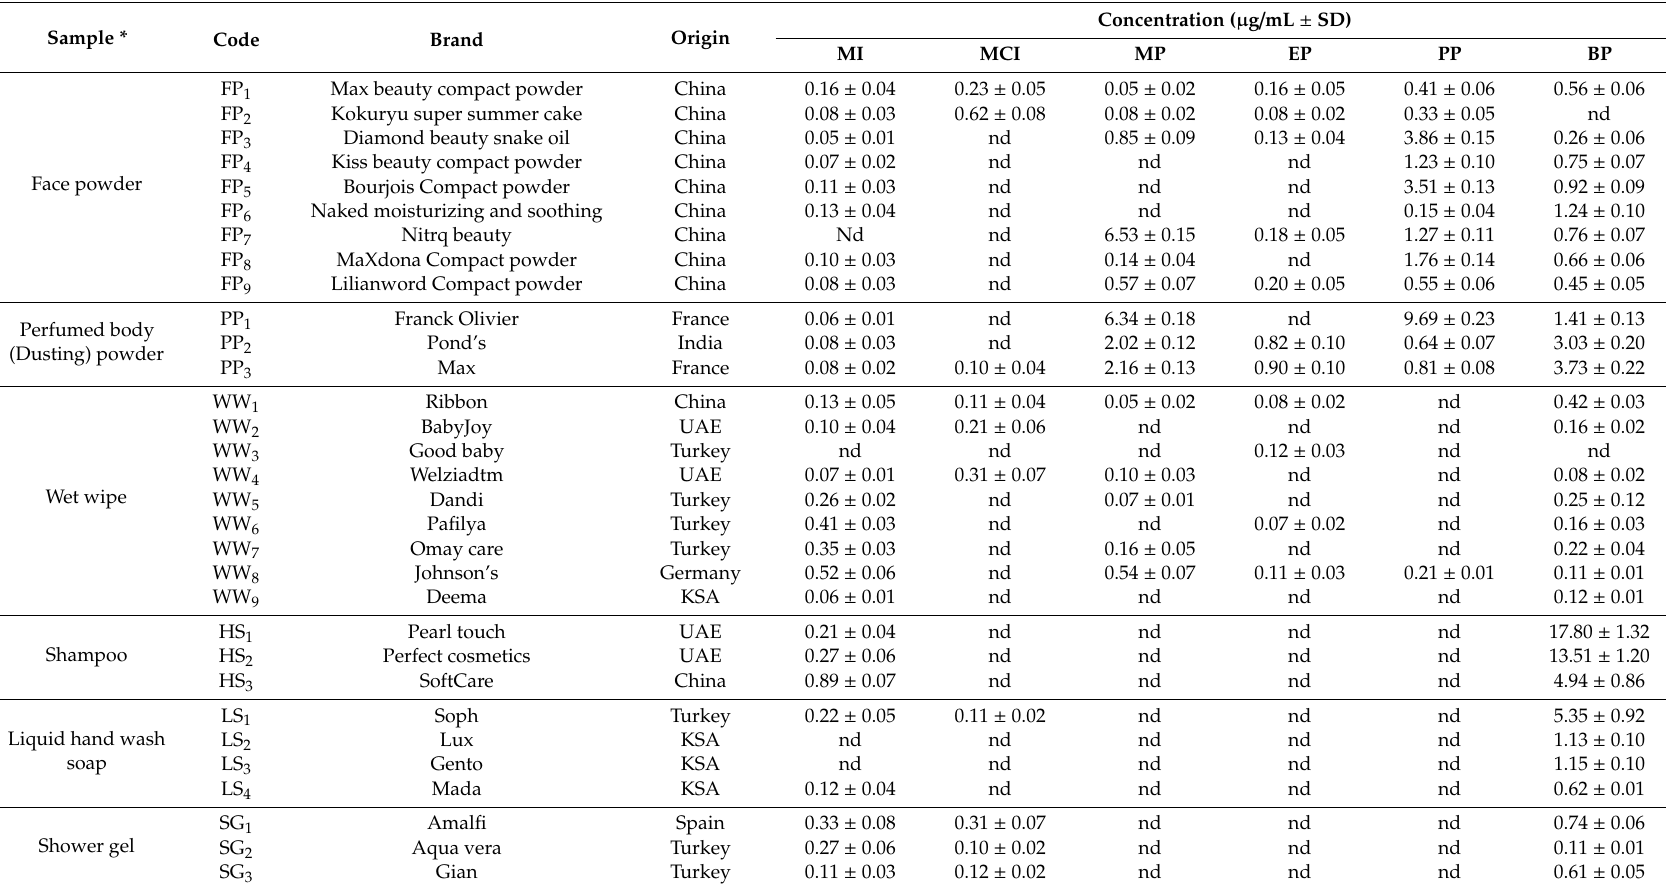
Table 4. Amounts of isothiazolinones and parabens obtained in cosmetic products of di ff erent brand and